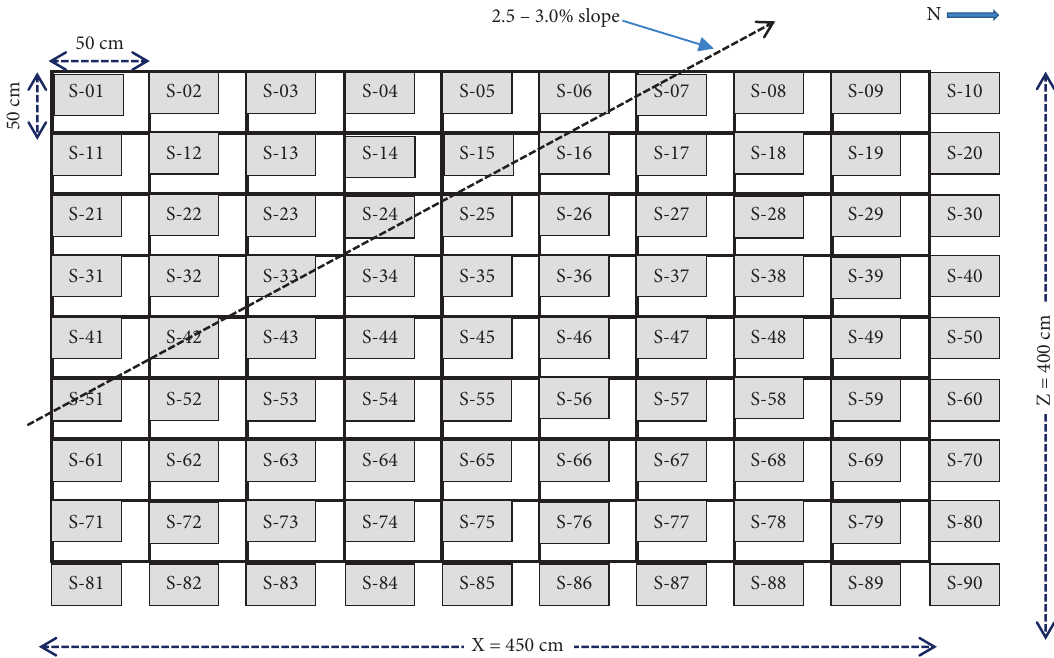
Figure 4: The sampling sites of soil in each experimental plot (the experimental plot measured 450cm ( X ) × 400cm ( Z ); the number of soil samples � 90 per plot, i.e., S-01 through S-90). Table 3: The effect of the 20-year-old amendment of industrial waste, lime, and cassava-leaf compost on the soil Cu concentration. Treatment